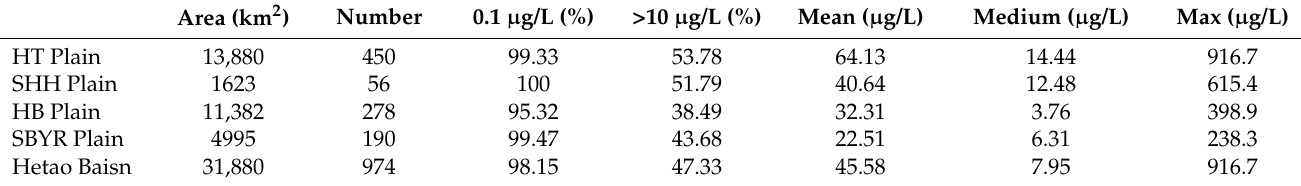
Table 1. Statistical table of arsenic content in shallow groundwater of the Hetao